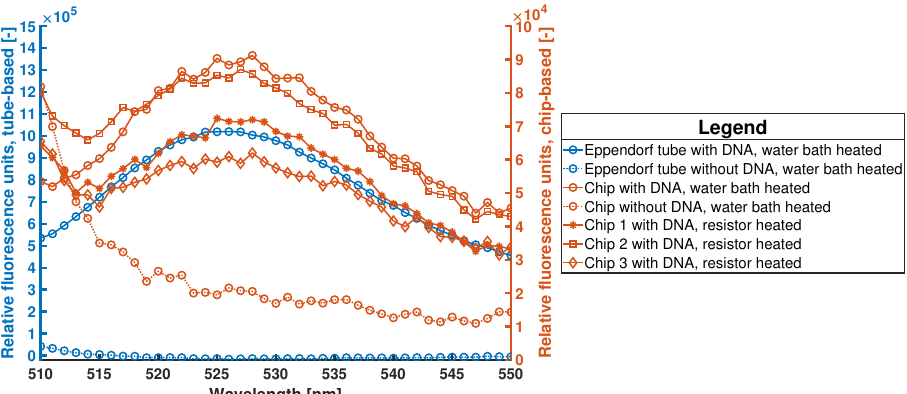
Figure 15. Fluorescence signal of DNA-binded EvaGreen dye after MDA reactions. The reactions are performed inside an Eppendorf tube and on-chip. As heating, two different methods are used, namely a water bath (for both the Eppendorf tube and chip) and the on-chip resistive heater (3 chips). The fluorescence intensity cannot be used as a value to quantify the amount of DNA [44]. The two blue lines with circular points are the MDA (continuous line) and NTC (dashed line) performed inside an Eppendorf tube. The two orange lines with circular points are the MDA (continuous line) and NTC (dashed line) performed inside a water bath heated chip. The three continuous orange lines with asterisks, squares, and diamonds represent the signals obtained after MDA reactions performed inside chips while using the integrated